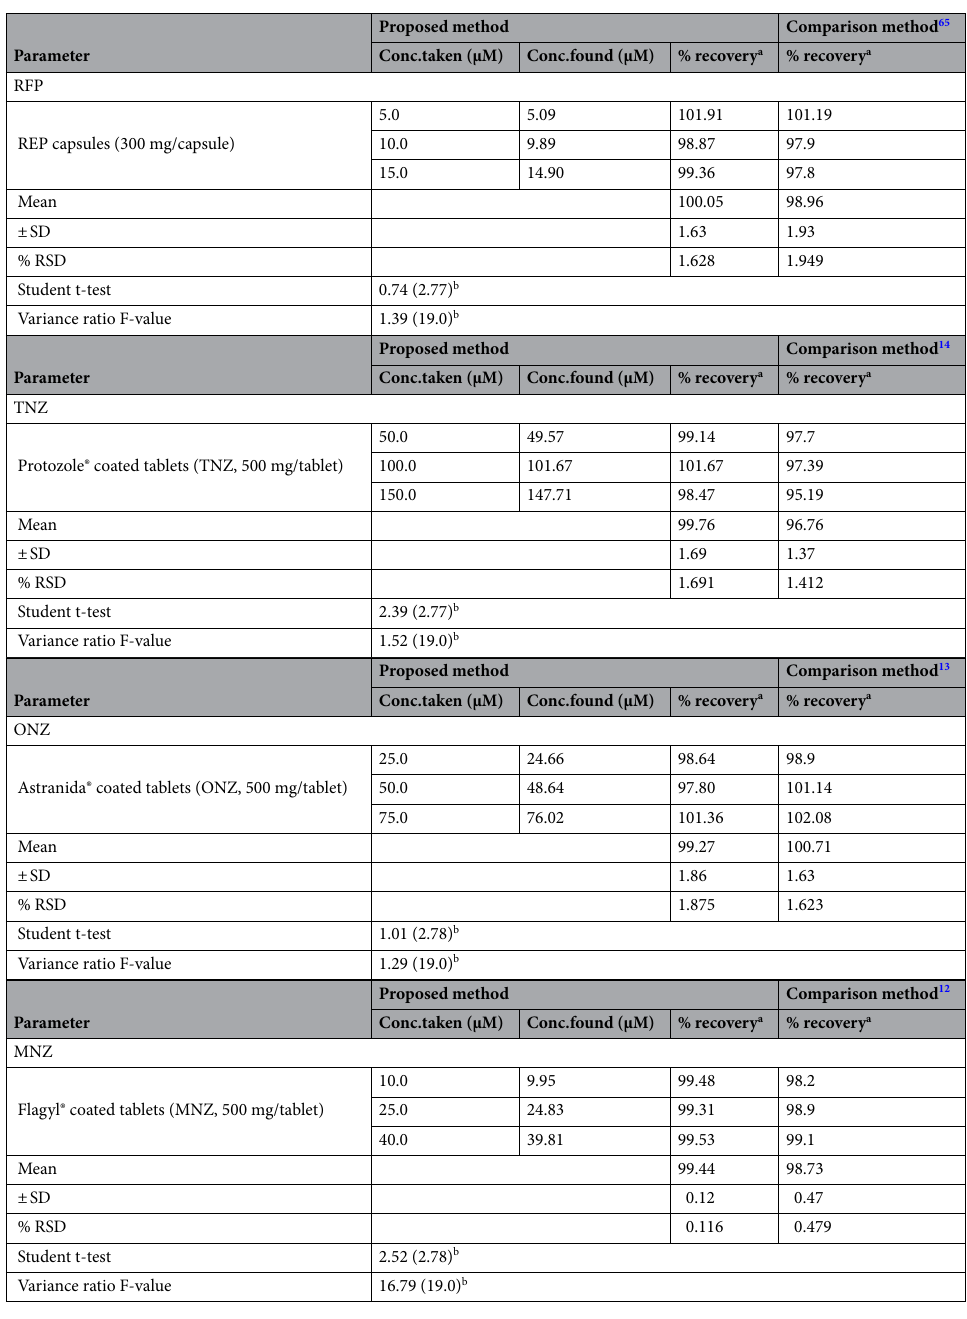
Table 4. Application of the proposed method for the determination of the drugs in dosage forms. a Mean of three determinations. b Values in parenthesis are the tabulated t- and F-values at p = 0.05 64